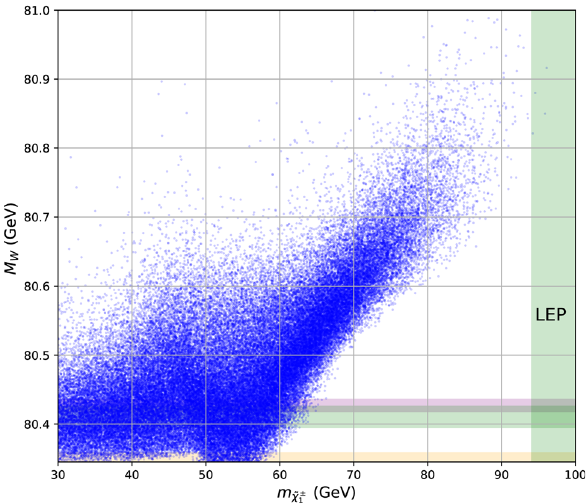
Fig. 1 W boson mass vs lightest chargino mass for points generated in the ‘MSSM without μ -term.’ The orange, purple and green horizontal bandsshowtheSM,TevatronandworldaveragemassesfortheWboson mass respectively; the vertical green band shows the LEP constraint on the lightest